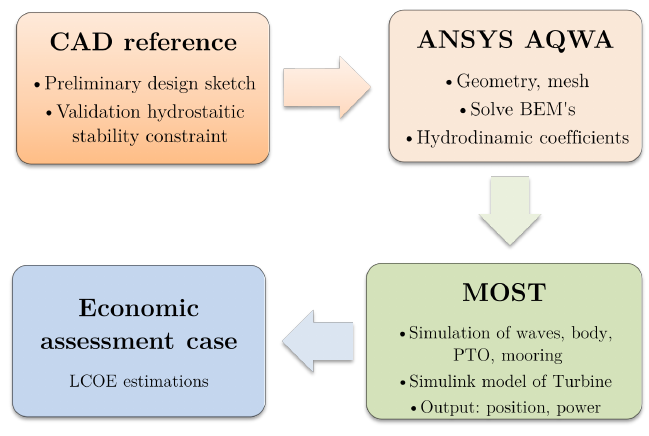
Figure 4. General